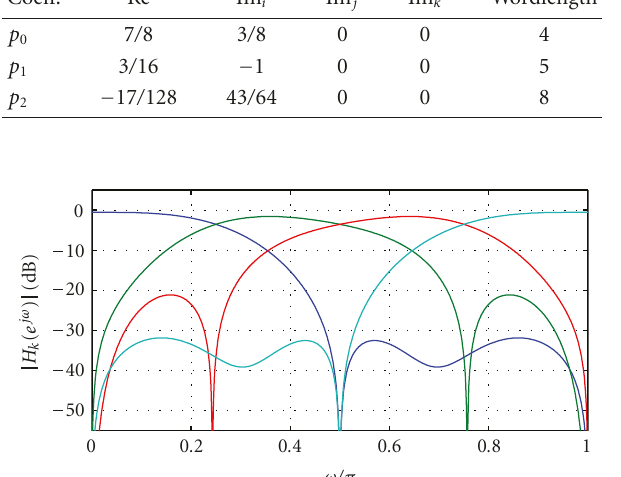
Table 3: Rational coe ffi cient values for PMI LP PUFB. Coe ff .